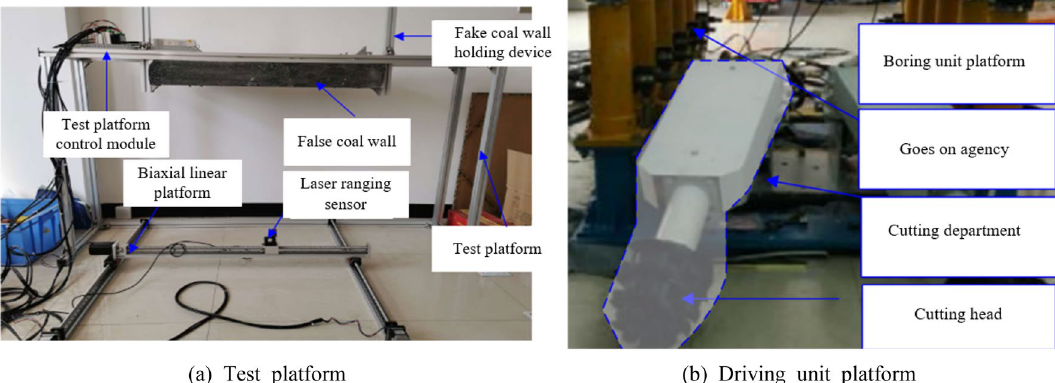
Figure 7. Experimental platform.